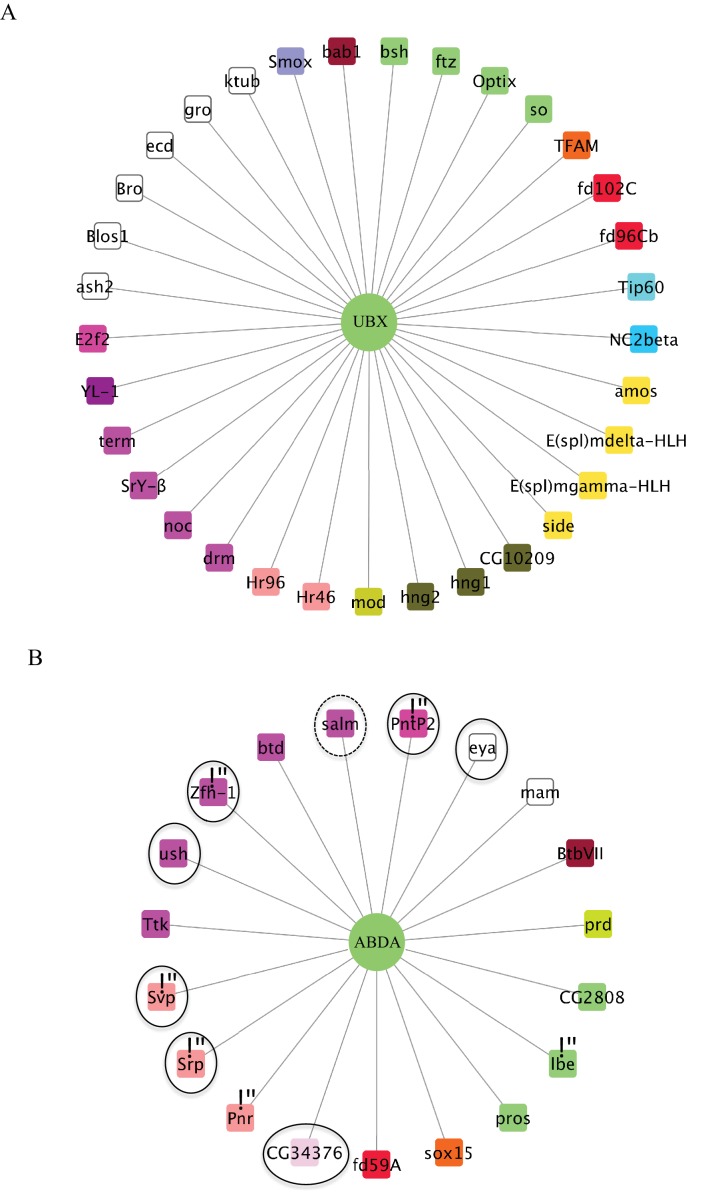
Representation of the Ubx- (A) and AbdA-specific (B) interactomes.Colour code is as in Figure 3. TFs involved in gonad mesoderm or oenocytes specification, which correspond to AbdA-specific functions, are surrounded by a solid or dotted line, respectively. Star * denotes TFs involved in heart specification.